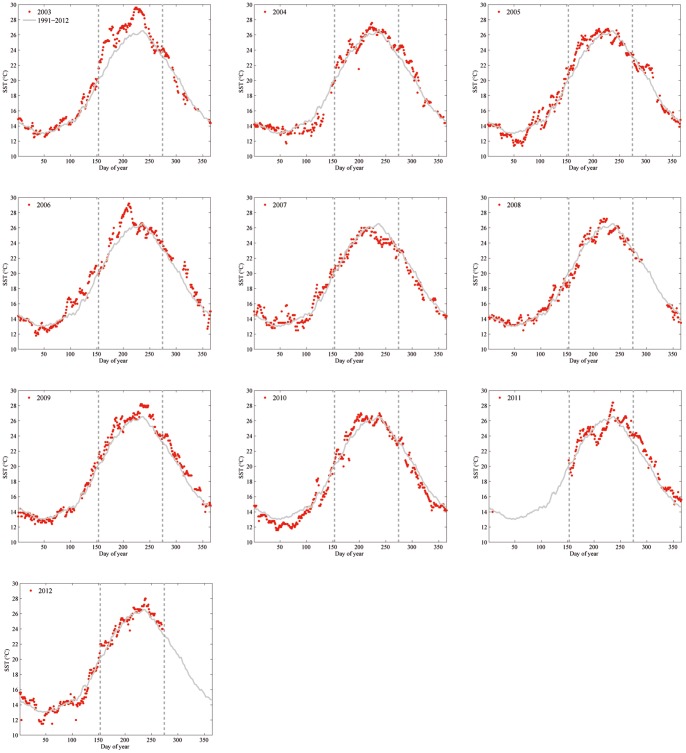
Annual thermal regime (2003–2012) and average SST for the data series 1991–2012.Dotted vertical lines delimit the summer period.